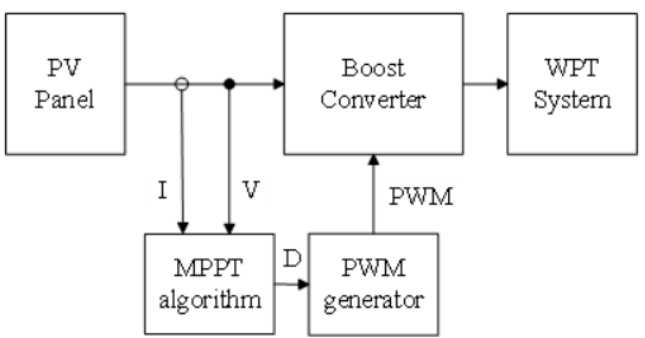
Figure 4. Power and control diagram of a photovoltaic generator (PVG) connected to a boost converter.